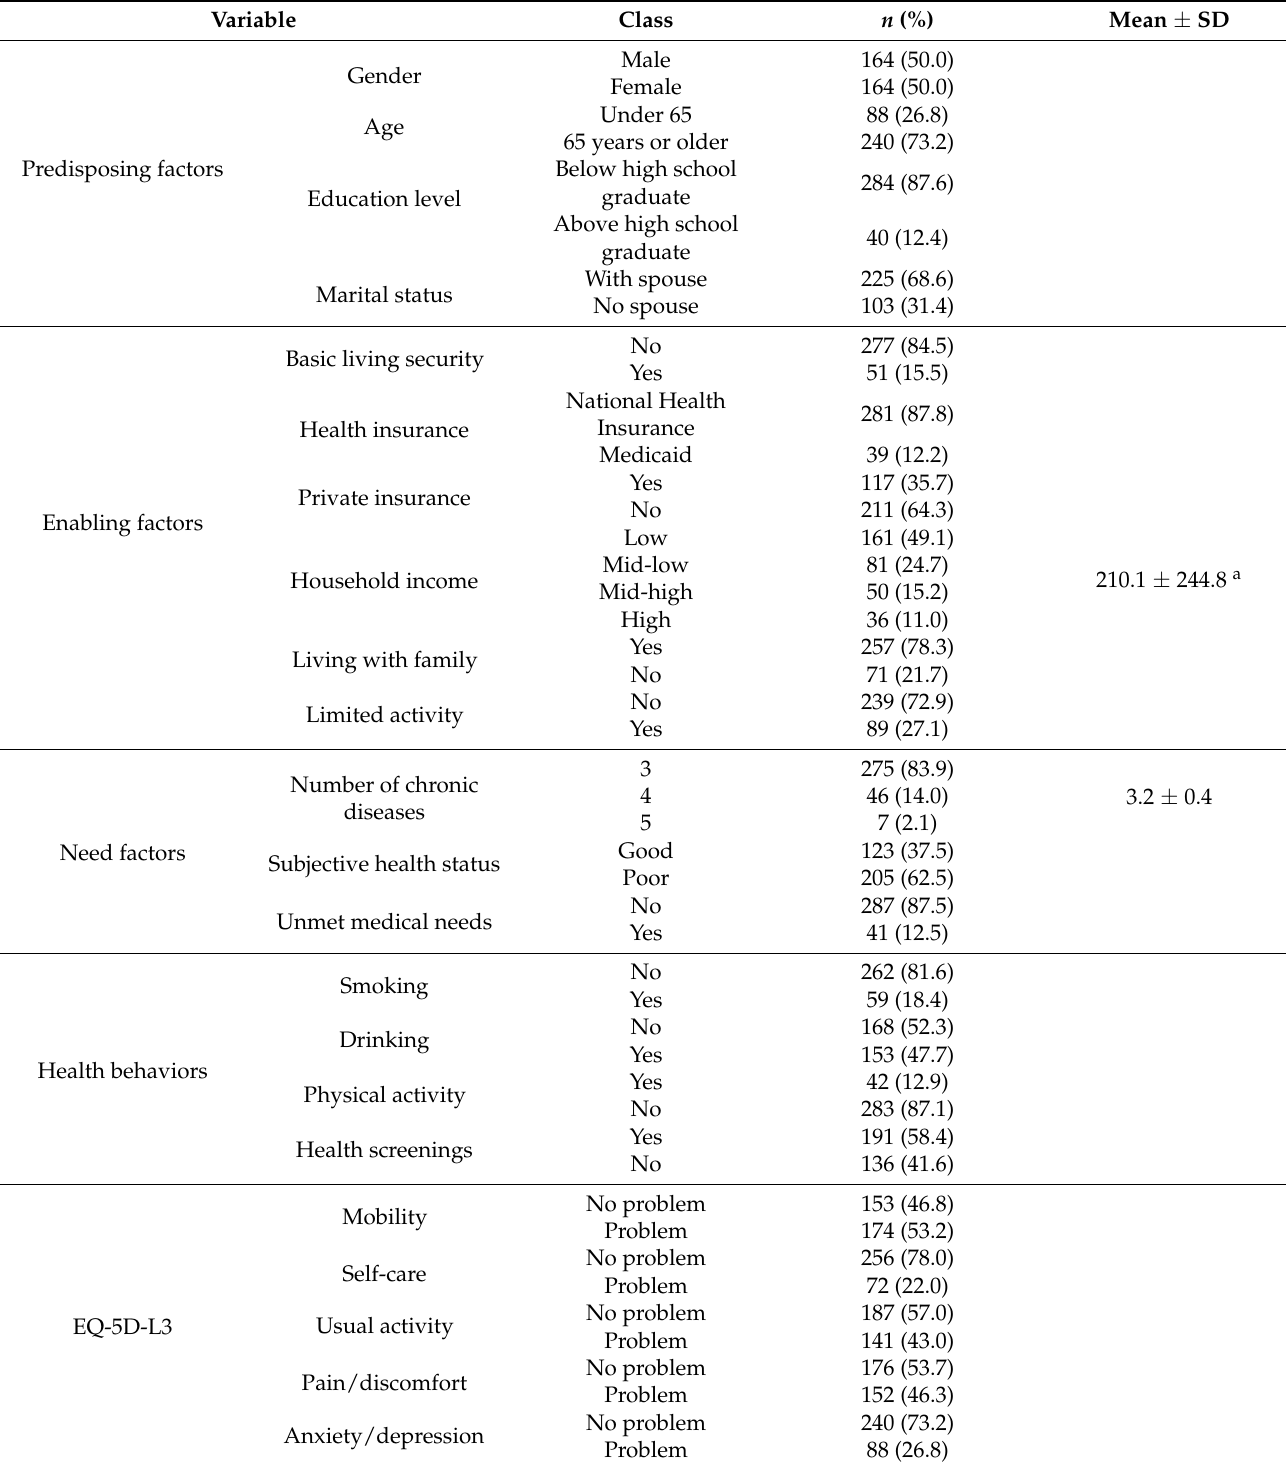
Table 1. General characteristics of patients with multimorbidity ( N = 328) (South Korea,